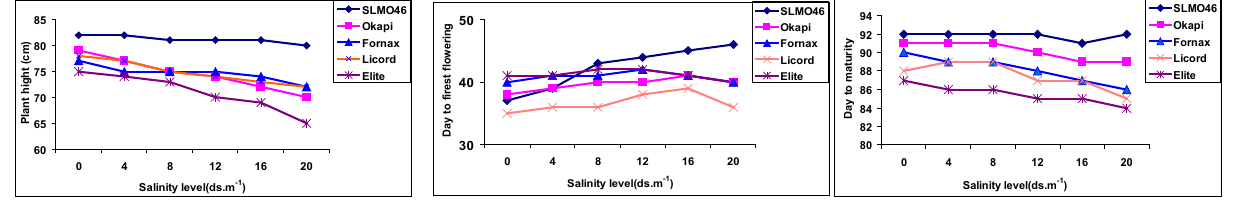
Fig. 2. Days to first flowering performance of five canola cultivars under different sa- linity levels